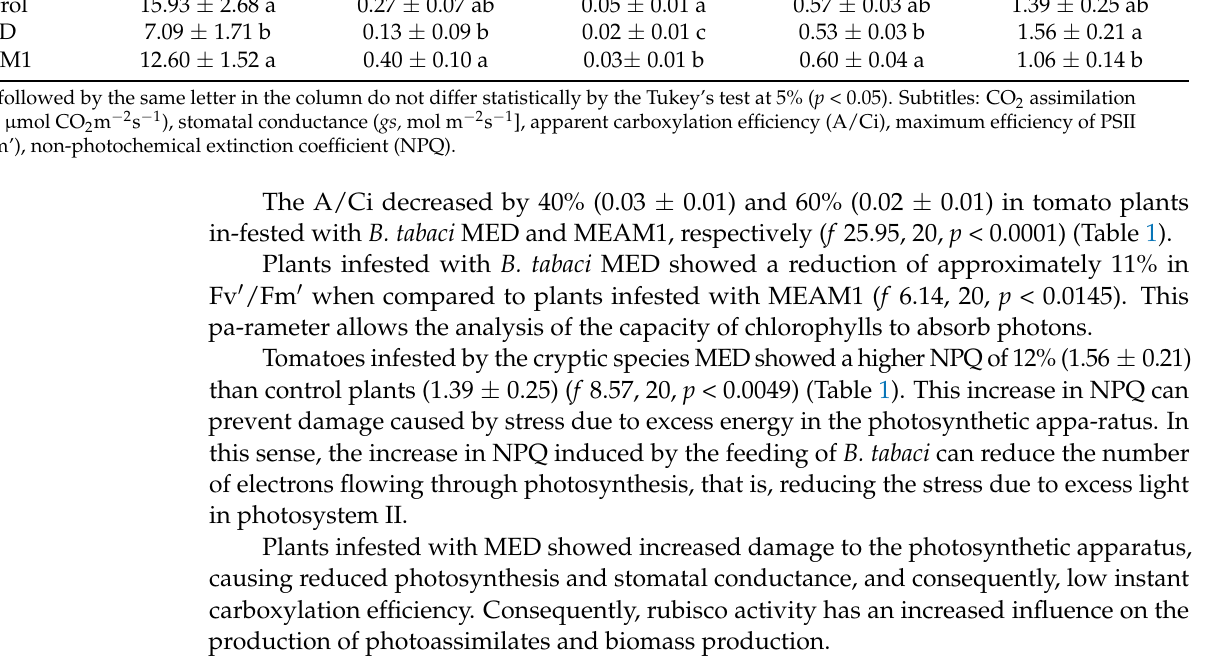
Table 1. Influence on physiological parameters caused by Bemisia tabaci (MED and MEAM1) in tomato. Treatments